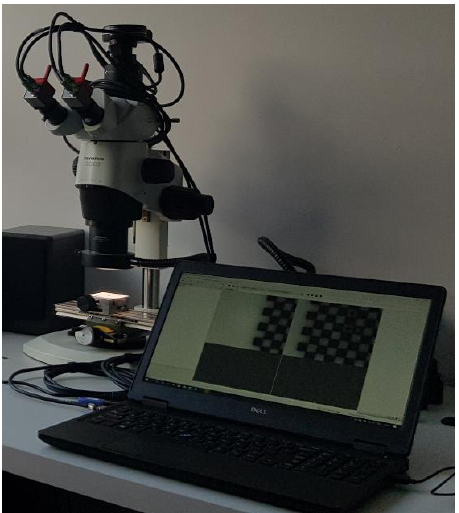
Figure 2. Equipment used for capturing the images of the tested specimen, and DIC analysis.